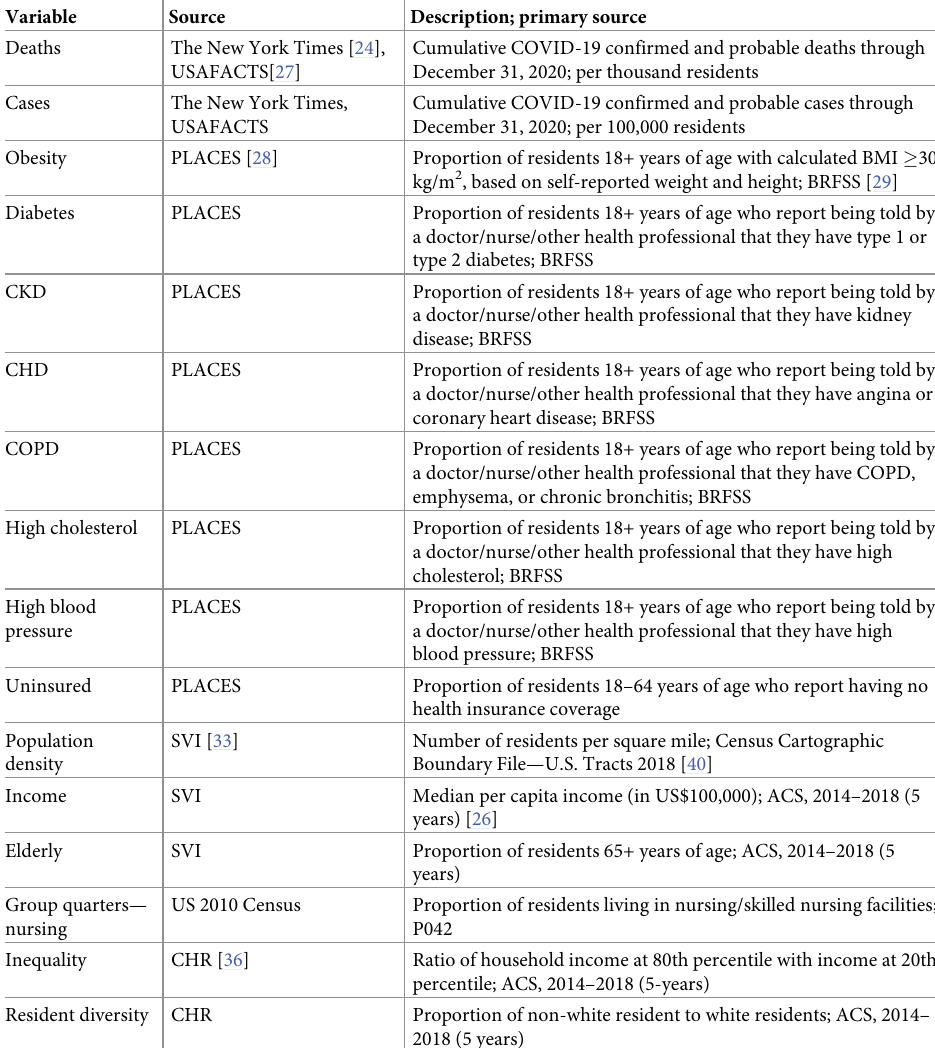
Table 1. Descriptions and sources for variables included in the